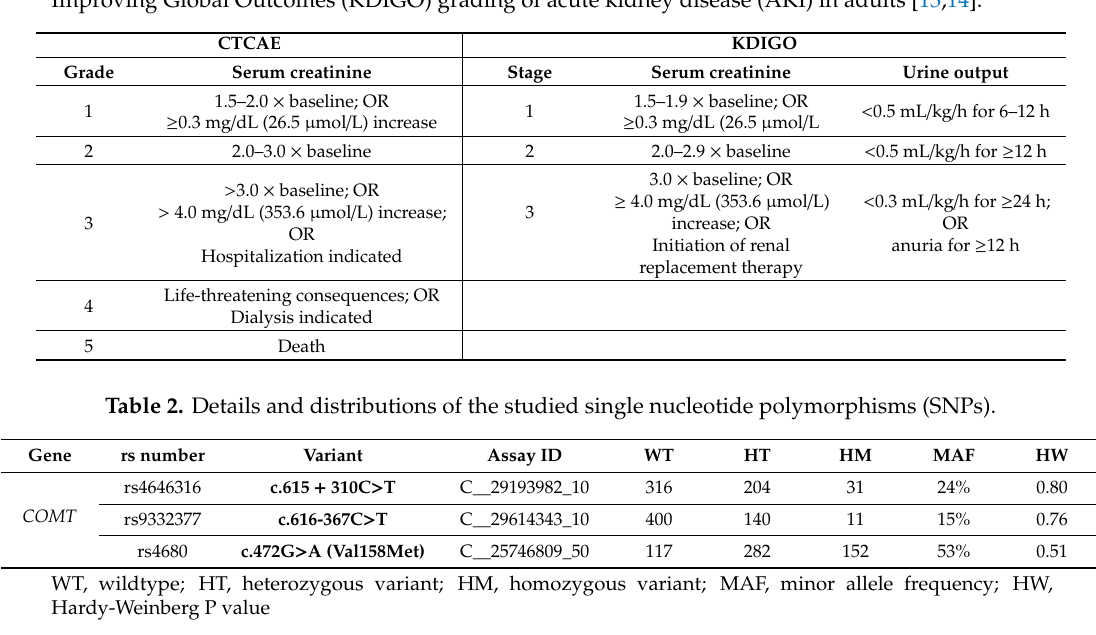
Table 1. Definition of Common Terminology Criteria of Adverse Events (CTCAE) and Kidney Disease: